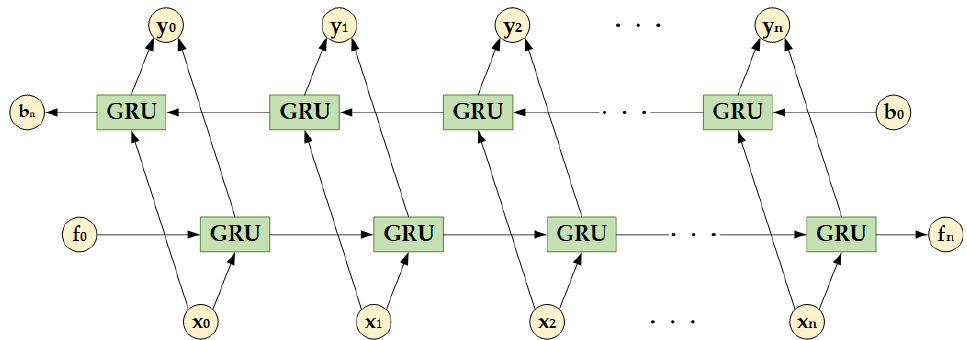
Figure 5. Network structure of BiGRU.